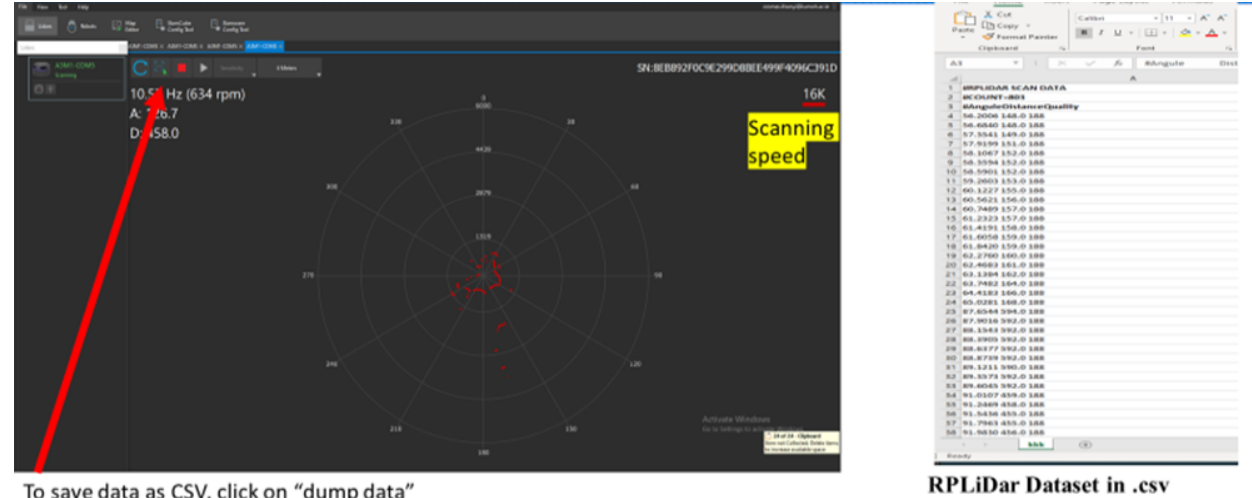
Figure 6. Visualization and saving of the RP-LIDAR data using RoboStudio